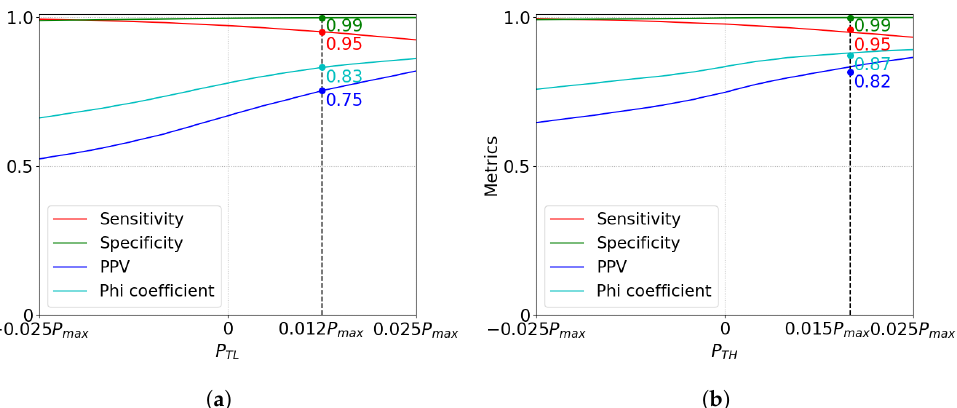
Figure 10. Performance of the algorithm using Sensitivity, Specificity, PPV, and Phi coefficient as functions of P TL and P TH : ( a ) Performance of the algorithm as a function of P TL . ( b ) Performance of the algorithm as a function of P TH